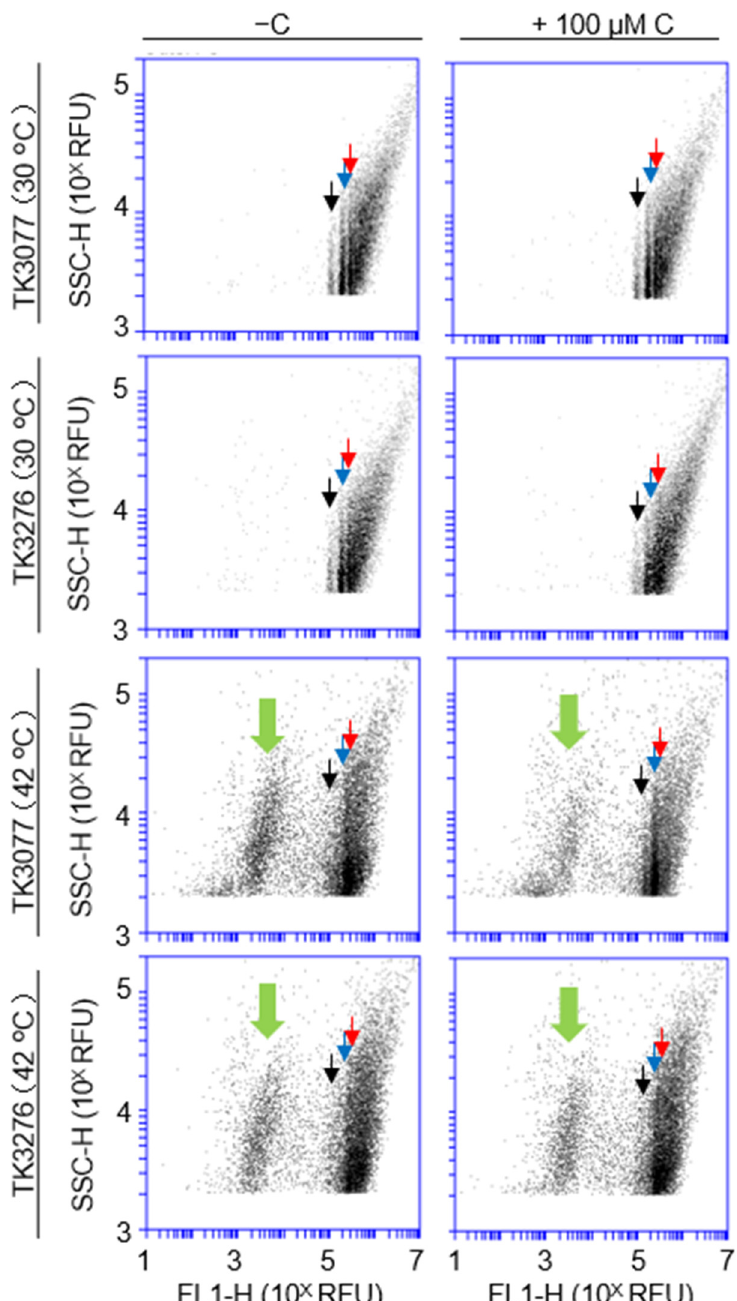
Figure 7. Effect of vitamin C on the ploidy of recAts polA cells in permissive and restrictive conditions. In the early logarithmic growth phase (O.D. 600 = 0.1), the TK3077 ( recAts polA ) and TK3276 ( recAts polA ∆ hslO ) cultures were divided into four portions, and each portion was incubated at 30 ◦ C and 42 ◦ C either with or without vitamin C for 16 h. The DNA levels in the cells were determined using PicoGreen staining. Strains and cultivating temperatures are indicated on the left of the panels. Whether vitamin C was added (with or without 100 μ M vitamin C) is indicated at the top of the panels. Arrowheads indicate ploidies as 1 (black), 2 (red), and 3 (blue). Thick green arrowheads indicate a position of anucleate cells. In total, 20,000 particles were analyzed with flow cytometry using fluorescence, with channel (FL-1H) on the x -axis and signal/side scatter signal (SSC) SSC-H on the y